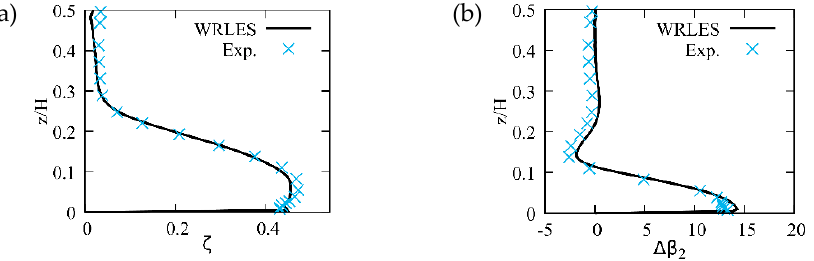
Figure 10. Pitchwise averaged ( a ) total pressure losses ζ and ( b ) flow angle deviation ∆ β 2 , down- stream of the blade (plane at x/C = 0.89 ). Experimental data from Krug et al. [23].